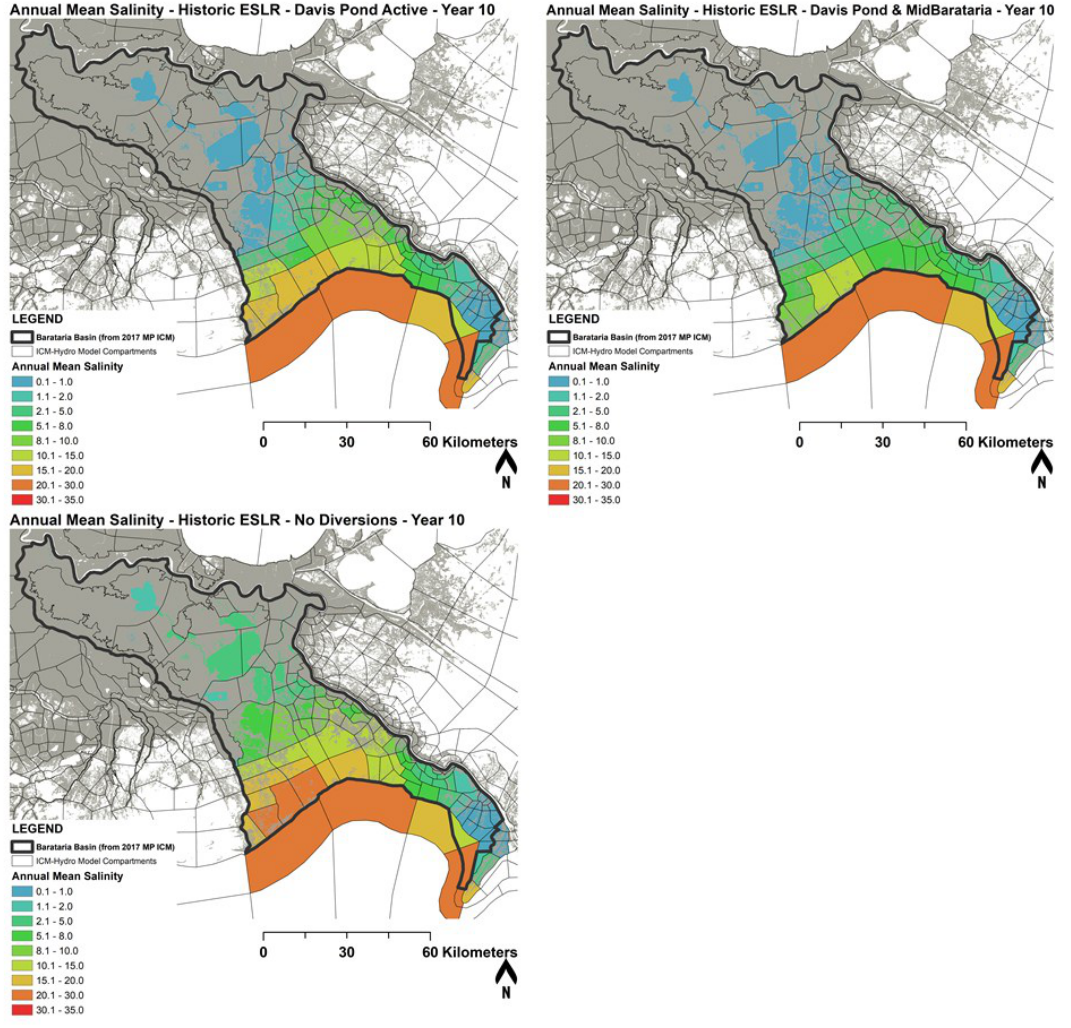
Figure 10. Model-predicted mean annual salinity under historic sea level rise rates during year 10 with only Davis Pond diversion active ( top left ), with both Davis Pond and Mid-Barataria diversions active ( top right ), and without any diversions active ( bottom left ). Figures for year 25 are provided in Supplementary